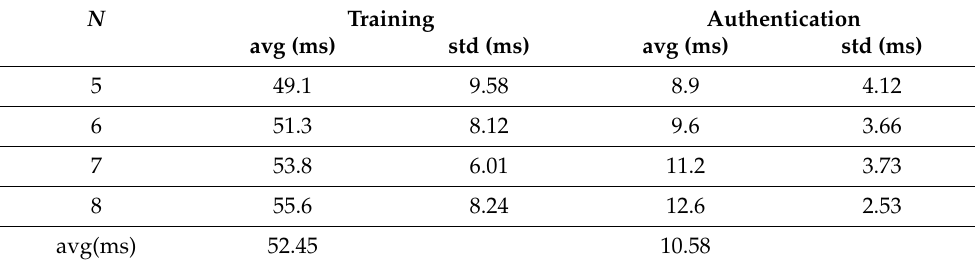
Table 6. The running times of training and